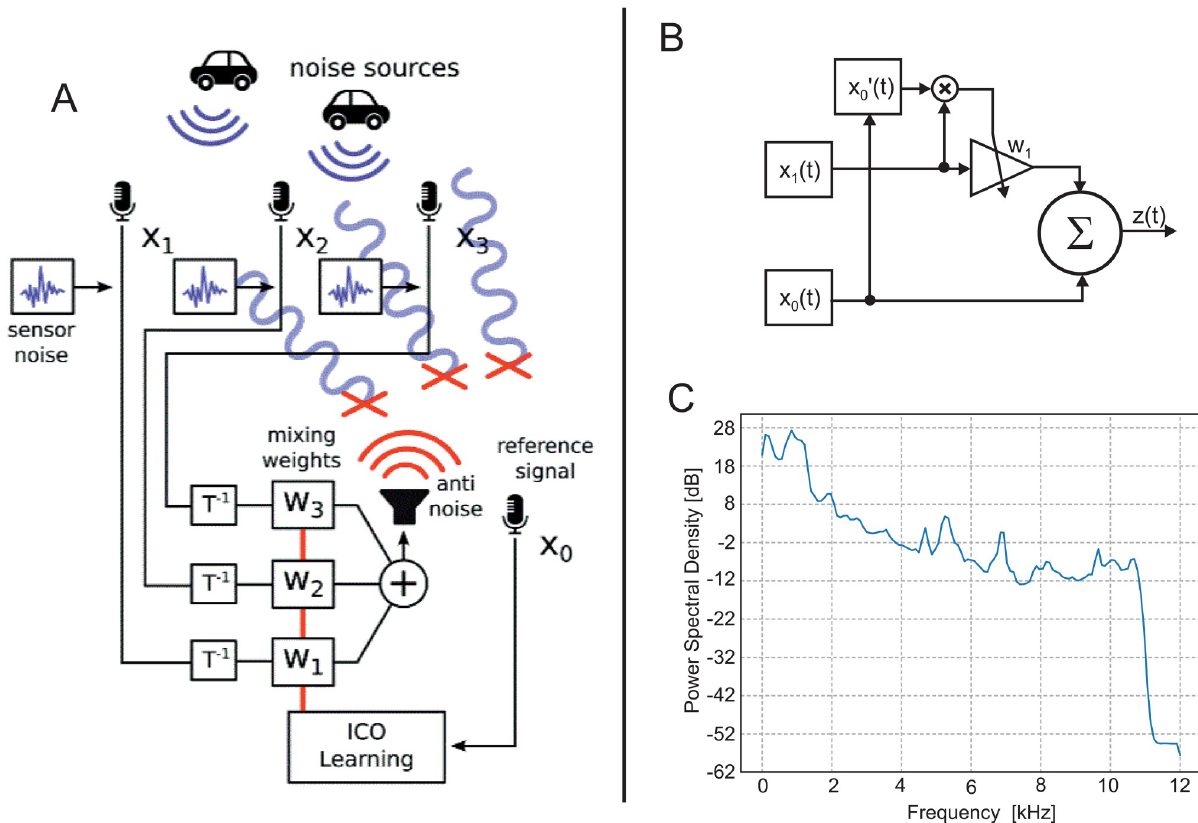
Fig 2. ICO learning for active noise reduction. A) Illustration of the active noise cancelling architecture. A set of control microphones, x 1 , x 2 and x 3 , records ambient noise. ICO learning is used to learn parameters for mixing the recorded noise to produce a suitable anti-noise to cancel at the reference recording site ( x 0 ) that receives signals with a propagation delay Δ t relative to the earlier-arriving signals at the control microphones. B) Schematic of the conventional ICO rule. The triangle represents a synapse with changing weight. C) Power spectrum of the noise used for all tests.